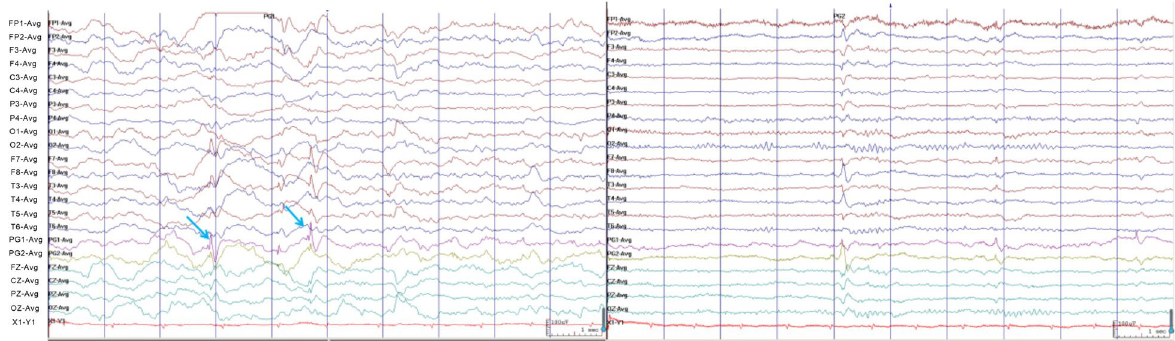
Fig. 2 EEG in the interictal period, indicating abnormal discharges in the bilateral temporal areas and sphenoid electrode area(blue arrow), significant on the left side